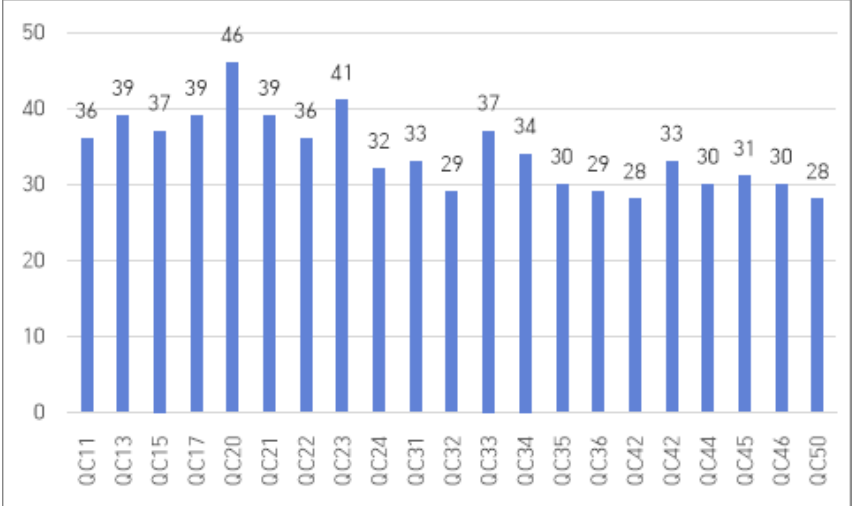
Figure 2. Count of vessels arrived at QC at various arrival times.